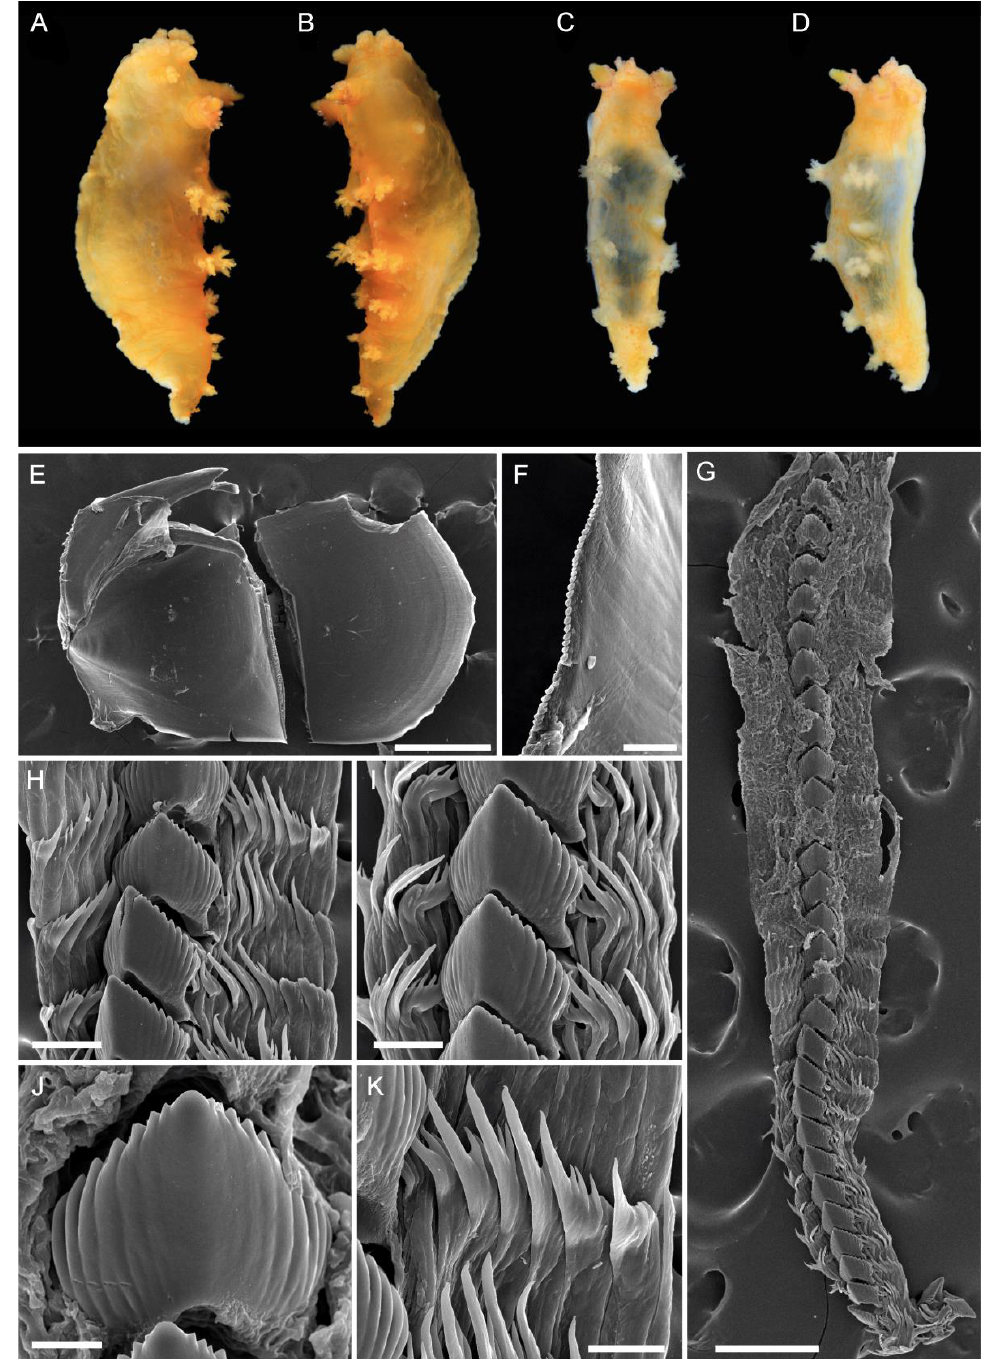
Figure 4. Dendronotus igori sp. nov., features of external and internal morphology (SEM). ( A , B ) — holotype MIMB44617, lateral view from the left ( A ) and from the right ( B ). ( C , D ) — paratype MIMB44618, dorsal view ( C ) and lateral view from the right ( D ). ( E ) — paratype MIMB44618, right jaw plate. ( F ) — paratype MIMB44618, masticatory process of the jaw. ( G ) — paratype MIMB44618, radula. ( H ) — paratype MIMB44618, middle radular portion; ( I ) — paratype MIMB44618, anterior radular portion. ( J ) — paratype MIMB44618, rachidian tooth. ( K ) — lateral teeth. Scale bars: ( E ) = 500 µm; ( F – I ) = 50 µm; ( G ) = 200 µm; (J, K) = 10 µm.